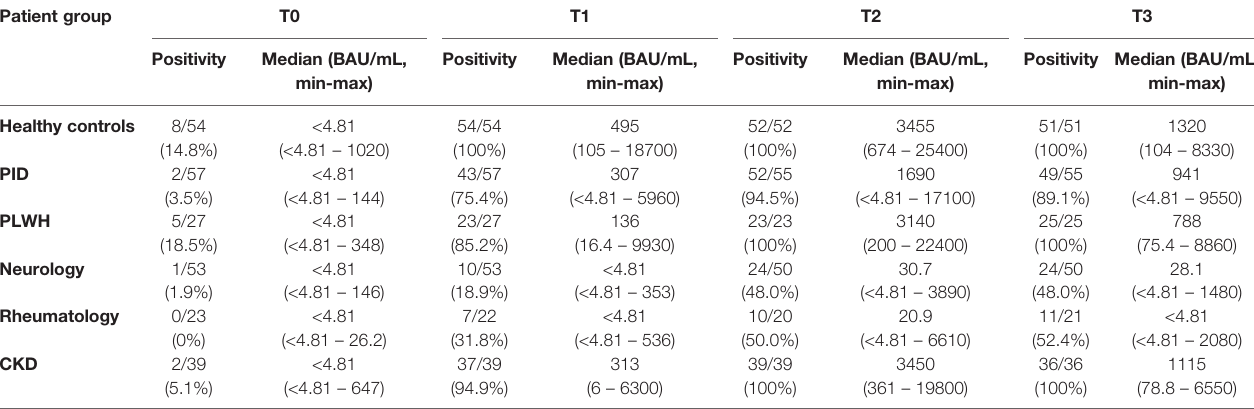
TABLE 2 | IgG anti-S1 antibody positivity (cut-off: 33.8 BAU/mL) at baseline (T0), at the time of second vaccine dose administration (T1), 10-14 days after administration of the second dose (T2) and 3 months after administration of the second vaccine dose (T3) for each patient group. Results are presented as number of positive patients per total number of patients. At each time point, also the median (min-max) IgG anti-S1 antibody concentration (BAU/mL) in the different patients groups is